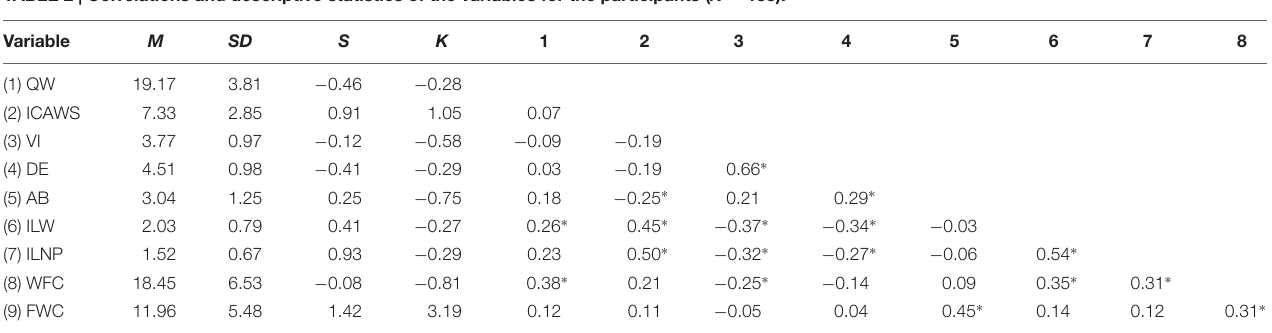
TABLE 2 | Correlations and descriptive statistics of the variables for the participants ( N = 188).